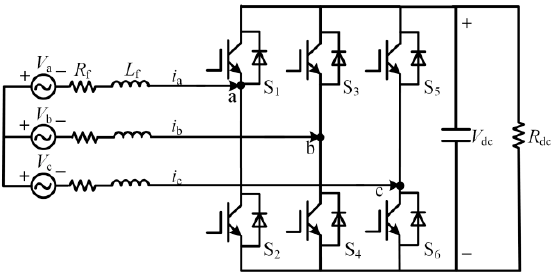
Figure 2. Topological structure of main circuit of a three-phase voltage source-type PWM